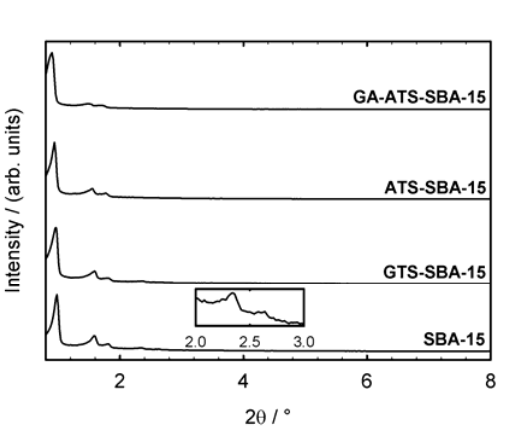
Table 1. Textural properties of the synthesized mesoporous supports: pore diameter (d